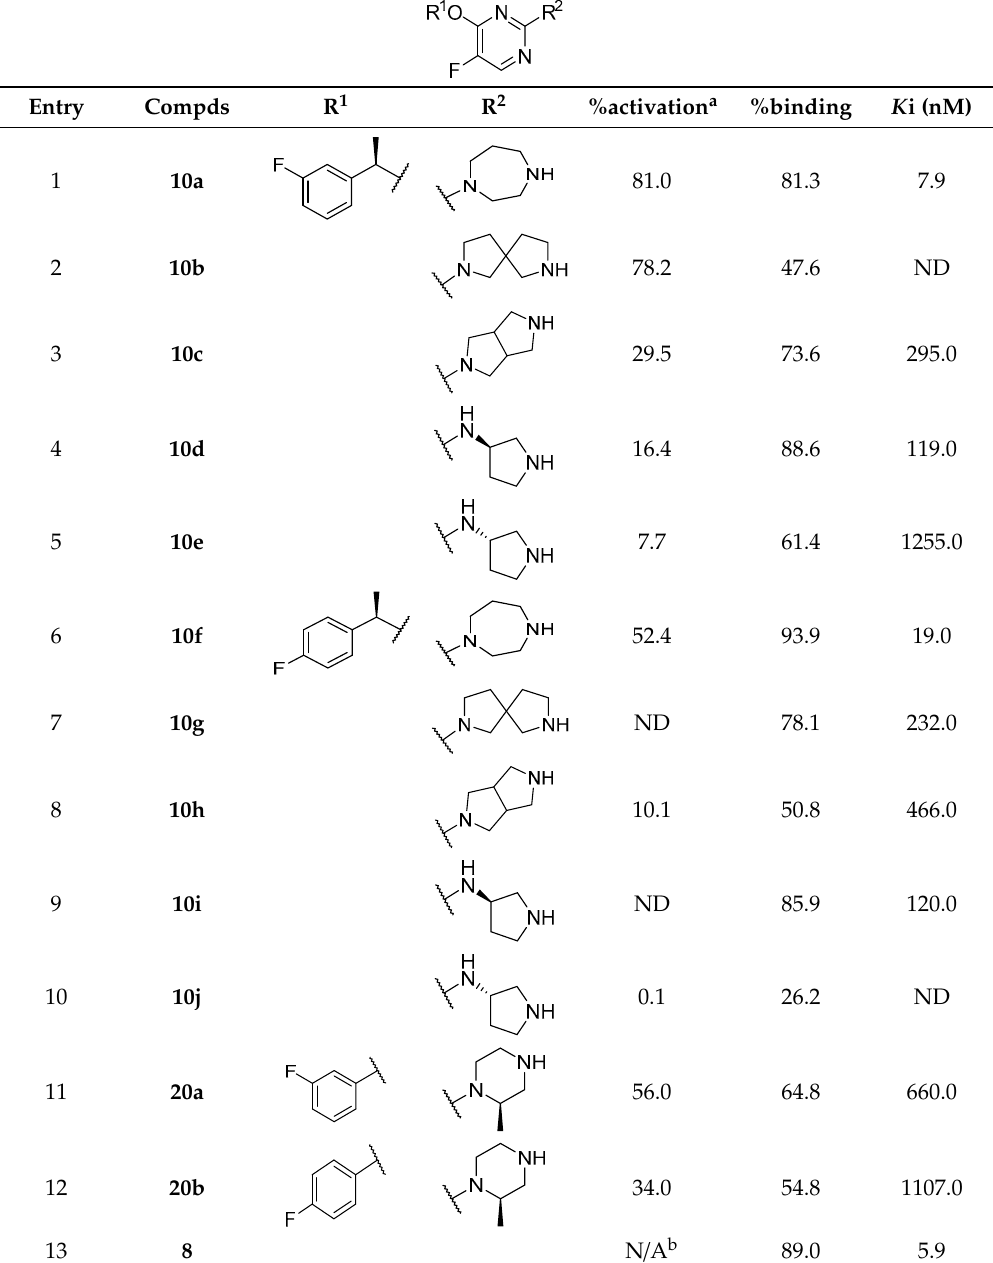
Table 2. In vitro activity of 2,4-disubsitutued pyrimidine against 5-HT 2C.